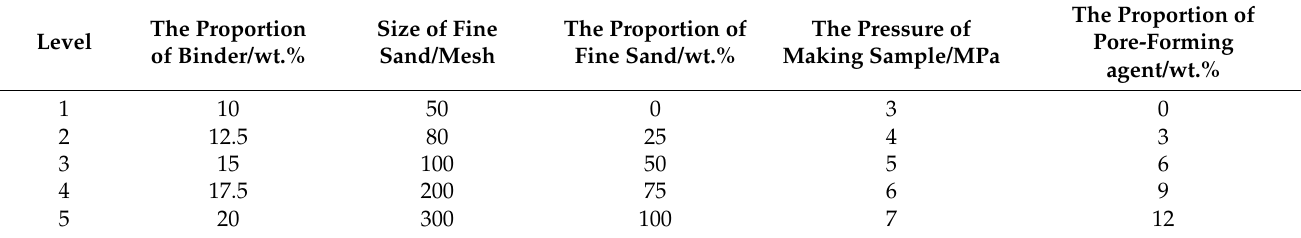
Table 1. Preparation parameters of the nozzle with different levels.